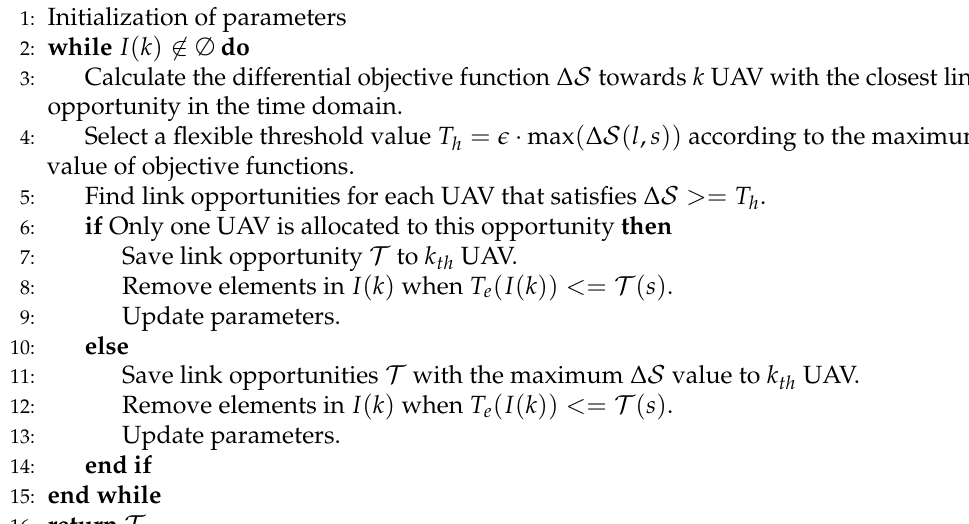
Algorithm 1 Pseudo-code of Greedy Based Algorithm for Time Sequence Resource